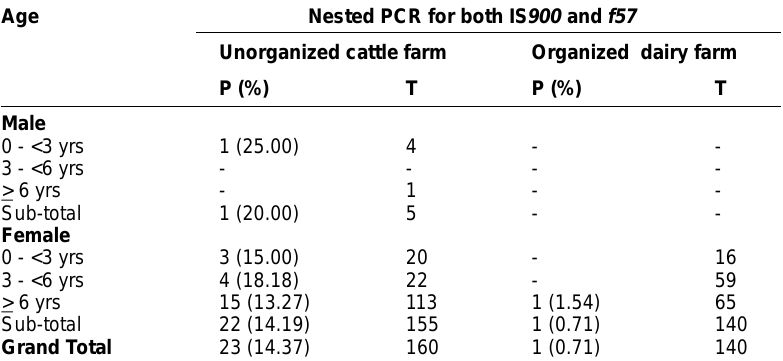
Table-3. Number of JD positive case from unorganized cattle farm and organized dairy farm with respect to age and sex. Nested PCR approach, targeted to both IS 900 and f57 sequences, was used to screen the fecal samples. Figure in parentheses indicate percentage, P = No. of positive samples, T = Samples